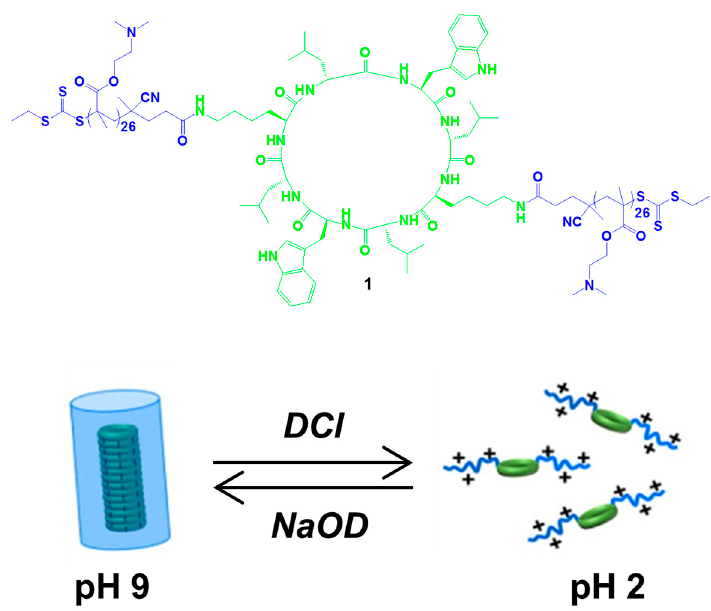
Figure 2. Molecular structure of the cyclopeptide-polymer conjugate 1 and illustration of pH responsiveness in the formation of NTs. Partially reproduced with permission from Ref. [35] (Copyright American Chemical Society, 2016).